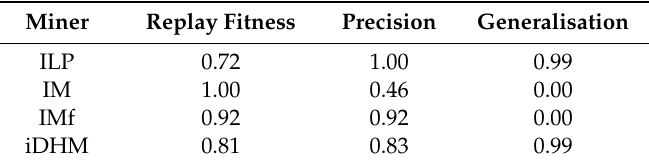
Table 4. Summary of process model quality.